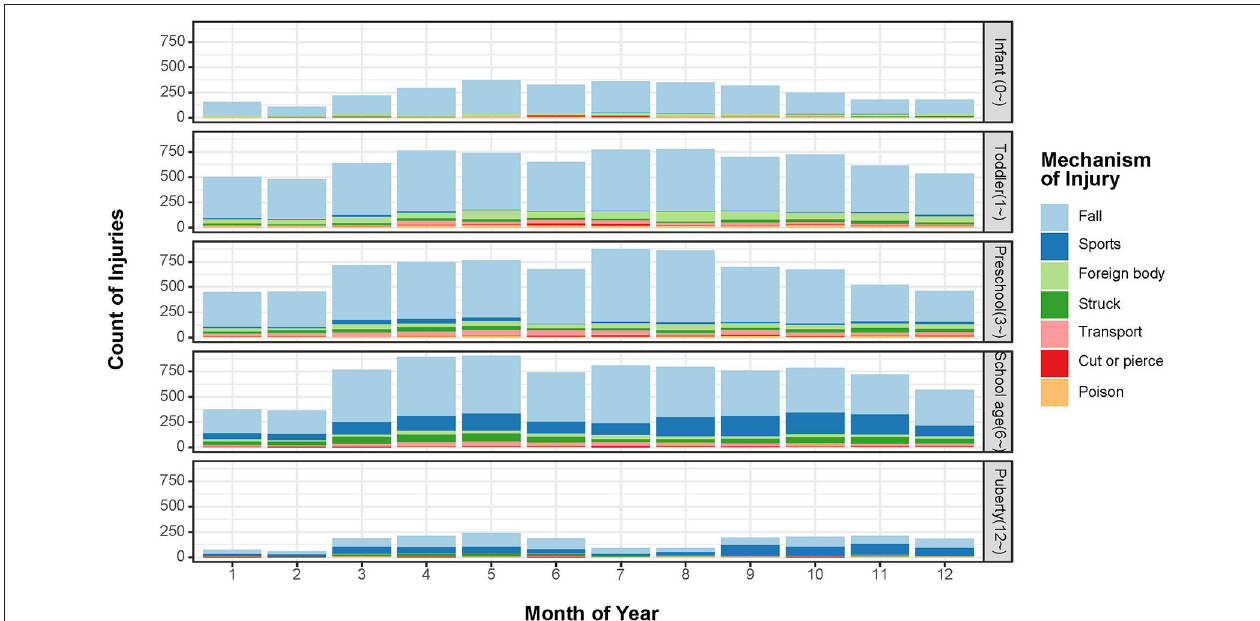
FIGURE 2 | Time trends of child unintentional injury mechanisms by age-group. X row represents the month of the year. Y row represents the count of injuries. Child unintentional injury mechanisms were stacked by different colors.